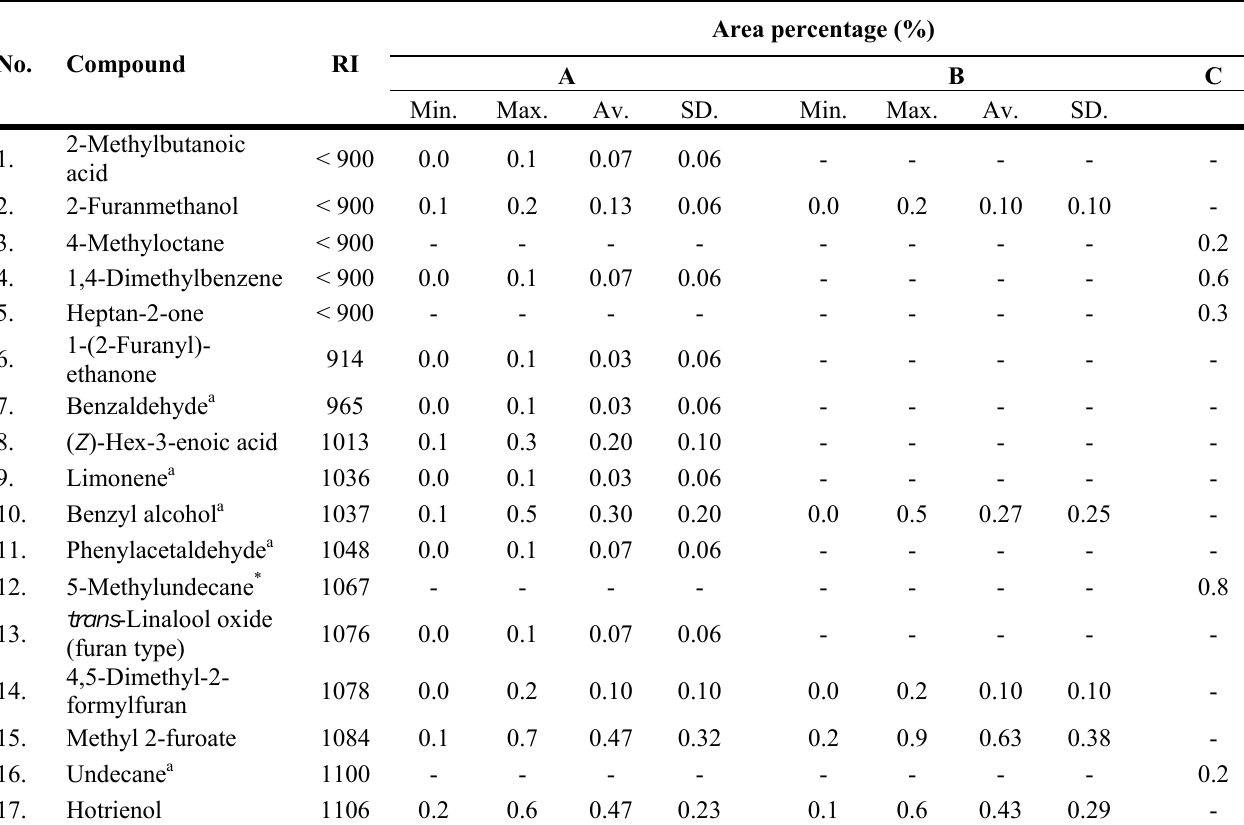
Table 1. Organic extractives composition from Mentha spp. honey and the